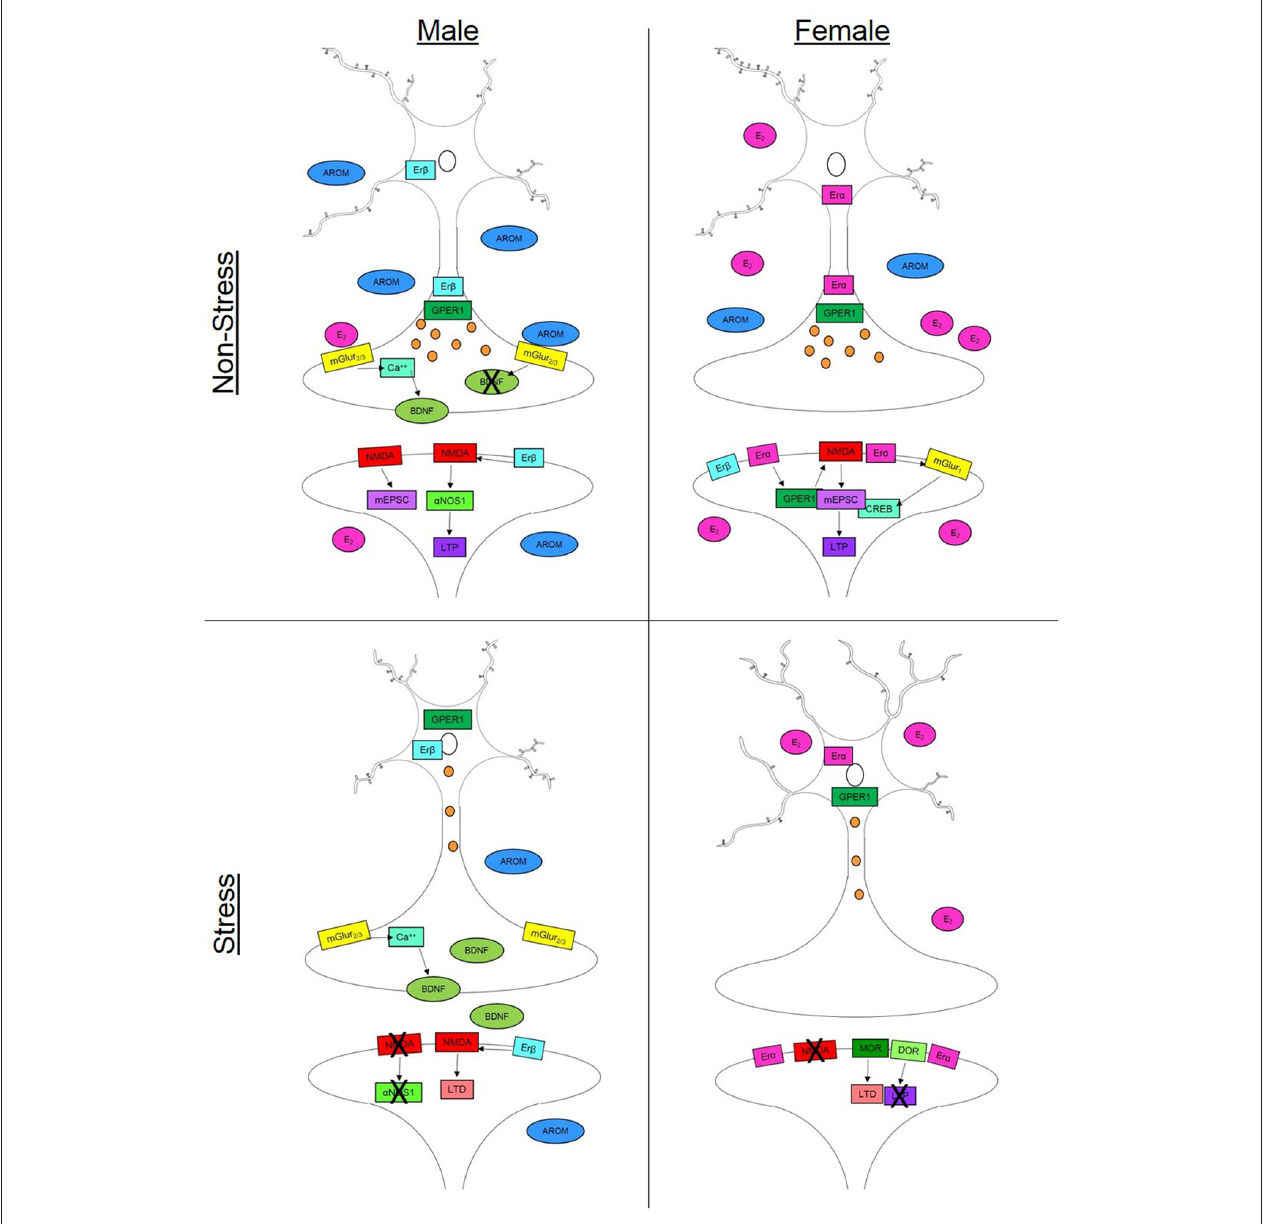
FIGURE 1 | Synaptic plasticity is driven by a variety of sex-specific signaling mechanisms in males and females that can vary throughout the brain. In non-stress conditions, females (top right) have increased spine density compared to males in the hippocampus (top left) but decreased dendritic length in the prefrontal cortex (PFC). This increase in spine density in the female hippocampus can occur via multiple estradiol (E 2 )-dependent signaling mechanisms. Binding with estrogen receptor alpha (Er α ) or the G-protein coupled estrogen receptor (GPER) can initiate N-methyl-D-aspartate (NMDA) channel signaling increasing mini excitatory postsynaptic currents (mEPCS) which ultimately drive long term potentiation (LTP). Estradiol can also act through Er α on metabotropic glutamate receptor 1 (mGluR1) which in turn drives cAMP response element-binding protein (CREB) phosphorylation in females. In males, NMDA activity is driven by activation of estrogen receptor beta (Er β ). This signaling cascade includes α nitric oxide synthase-1 ( α NOS1) which drives LTP in males but not females. In the male presynaptic neuron, E 2 -dependent activation of mGluR 2 / 3 initiates a calcium (Ca ++ ) signaling cascade which facilitates the release of brain derived neurotrophic factor (BDNF). Testosterone (AROM) can alter the release of BDNF and other aspects of synaptic plasticity in the baso lateral amygdala. In stress conditions, males (bottom left) show decreased dendritic branching in the PFC but slight increases in spine density in the hippocampus. Possibly accounting for this increase is the reduction in circulating steroid hormones which can allow for increased BDNF release in males. Females (bottom right) on the other hand, experience increased dendritic length in the PFC and hippocampus as well as a suppression of spine growth in the hippocampus following stress. Females exhibit changes in opiate receptor (OR) signaling that can drive long term depression (LTD)—specifically through mu- and delta-OR activity. In the presynaptic neuron, axonal labeling of Er α and GPER1 facilitates vesicle transmission down the axon in both males and females. However, in stress conditions (bottom panels), both receptors migrate to the nucleus thereby reducing vesicle trafficking.